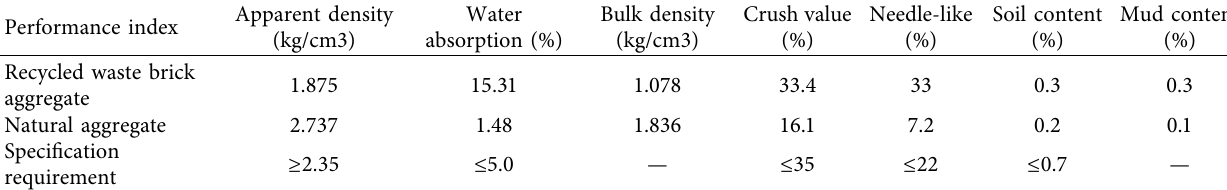
Table 1: Test results of properties of recycled coarse